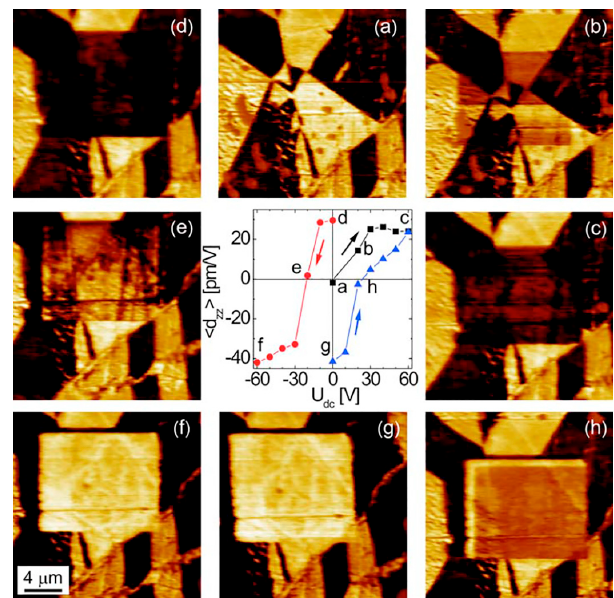
Figure 8. Local switching by progressive step-by-step poling of the area. Out-of-plane PFM images of BiFeO 3 ceramic after poling an inner area of 10 × 10 μ m 2 subsequently at different bias voltages: ( a ) Virgin state U dc = 0; ( b ) +20; ( c ) +60; ( d ) 0; ( e ) − 20; ( f ) − 60; ( g ) 0; and ( h ) +20 V. The average PFM signal of this area after these and more poling procedures in zero bias yields a hysteresis curve vs. U dc (central inset). Adapted from [89], with permission from © 2007 AIP Publishing LLC.